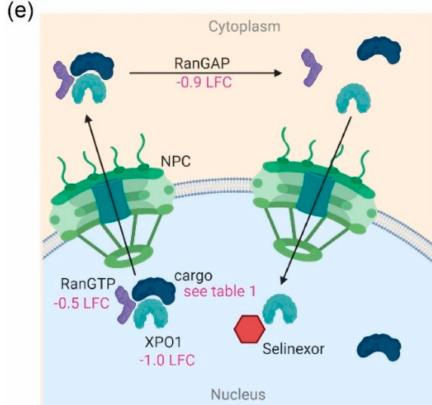
Figure 1. Midostaurin CRISPR knockout screen. ( a ) Screen design. ( b ) Volcano scatter plot showing significant positive and negative selection results. ( c ) Changes in levels of the two most e ffi cient sgRNAs targeting XPO1 in four replicate screens. ( d ) Enriched gene pathway analysis. ( e ) Schematic of nuclear pore complex (NPC) components with log-fold change (LFC) values from the screen indicated.